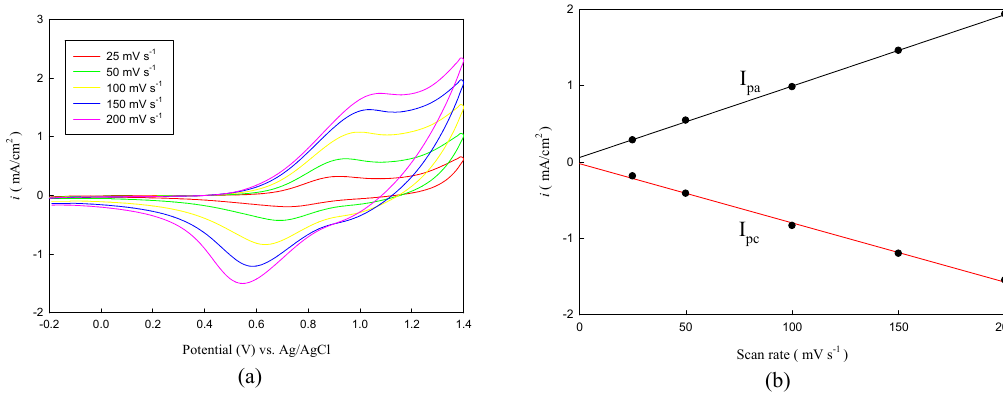
Figure 4. ( a ) CV curves of the P(TTPA- co -BDTA) film at various scan rates between 25 and 200 mV·s − 1 in 0.1 M LiClO 4 /ACN solution. P(TTPA- co -BDTA) film was prepared potentiostatically at 1.0 V; ( b ) Relation between peak current density and scan rate of the P(TTPA- co -BDTA) film in 0.1 M LiClO 4 /ACN solution.